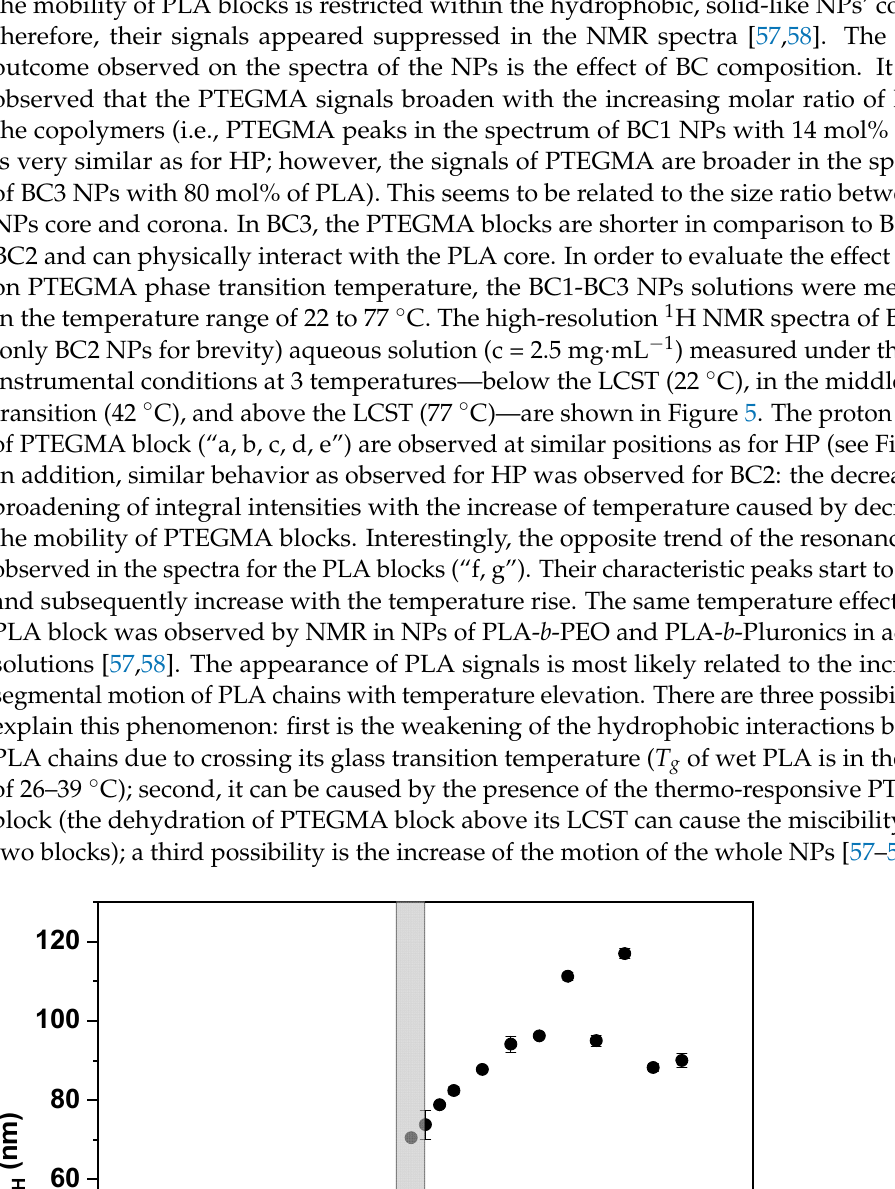
Figure 4. Hydrodynamic radius ( R H ) of PTEGMA homopolymer in water (c = 2.5 mg · mL − 1 ) measured as a function of temperature.